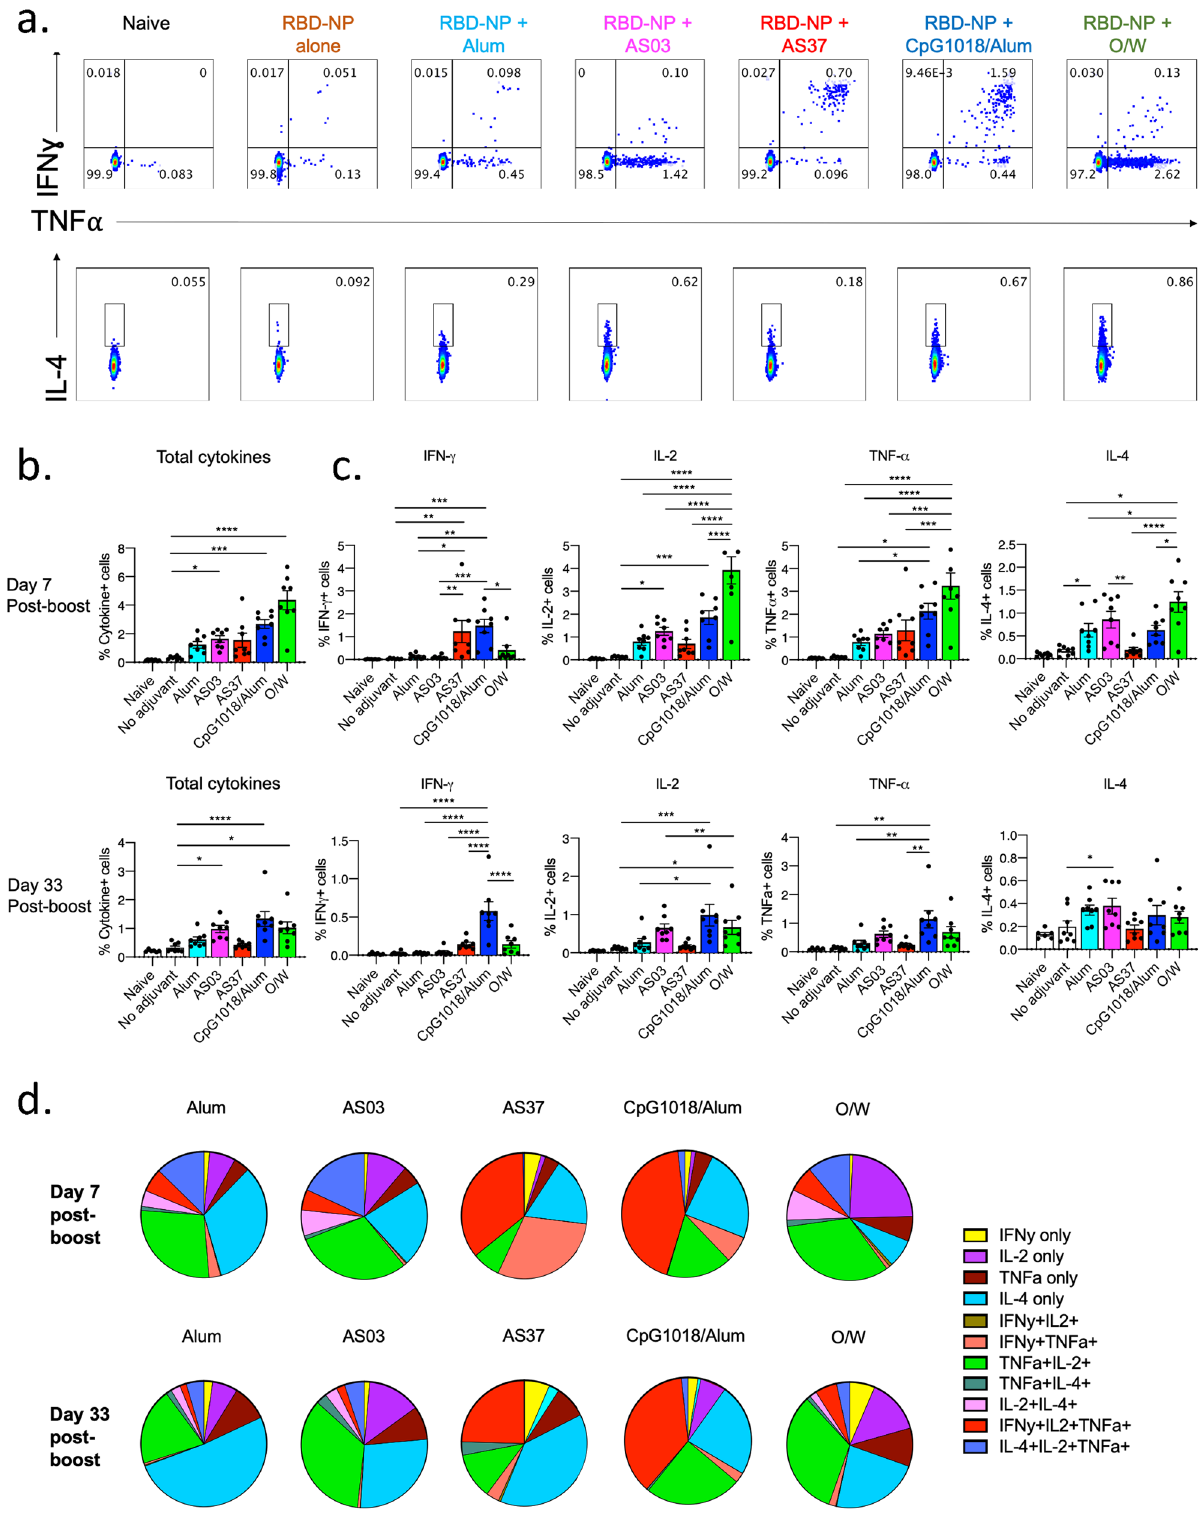
Fig. 3 Lung CD4 T cell responses to immunization with RBD-NP and adjuvants. a Representative fl ow cytometry plots of CD4 T cell cytokine production following stimulation with overlapping peptides from SARS-CoV-2 spike protein at day 7 post-immunization. b Frequency of total cytokine-producing CD4 T cells at day 7 and day 33 post-immunization. Error bars indicate mean ± SEM. c Individual cytokines produced by CD4 T cells in response to overlapping peptide pool at day 7 and day 33 post-immunization. d Pie charts representing the average proportions of cytokine-producing cells positive for either one, two or three cytokines. a – d Results from 2 independent experiments with n = 4 mice per experiment. P -values: * denotes p < 0.0332, ** p < 0.0021, *** p < 0.0002, and **** p <